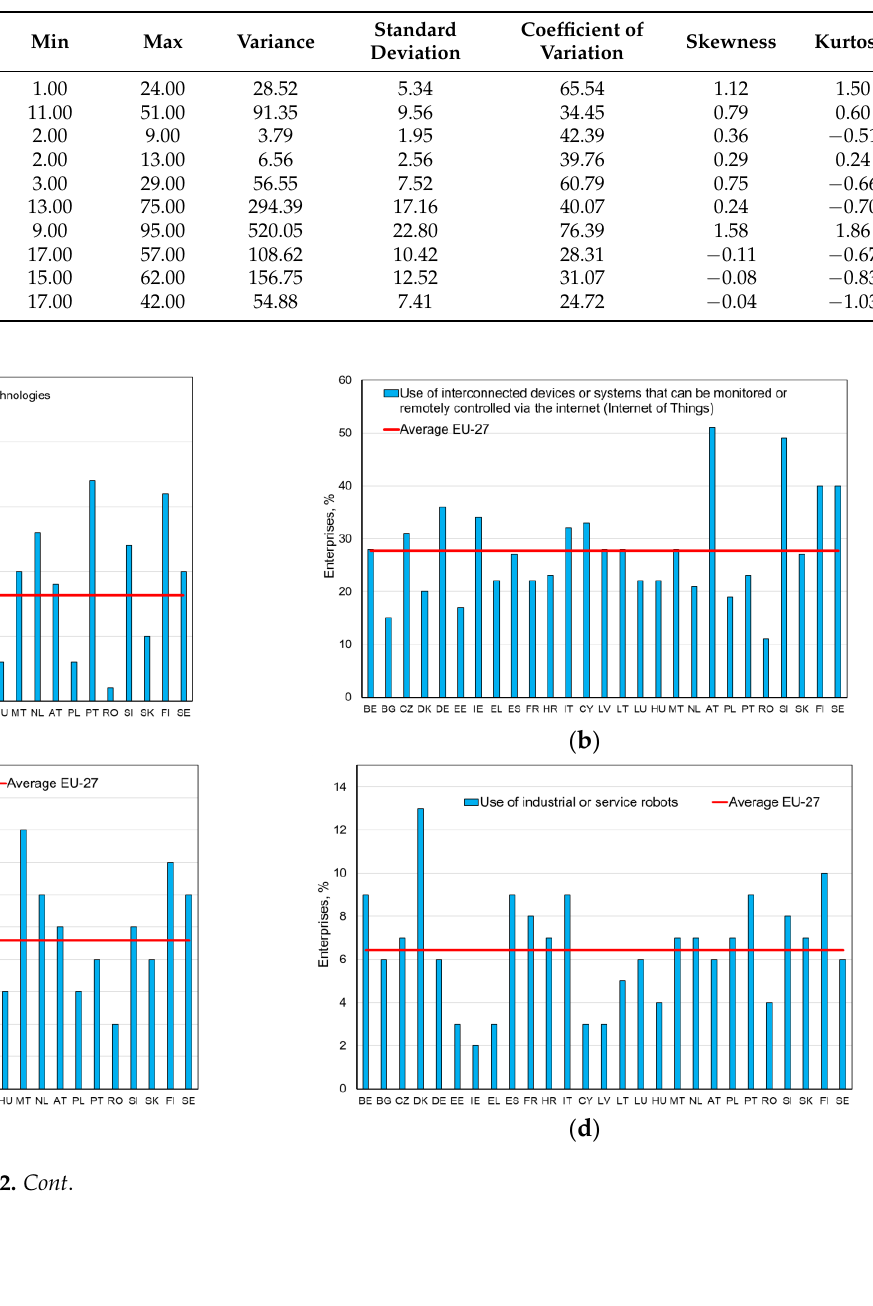
Table 3. Basic static parameters of studied variables.